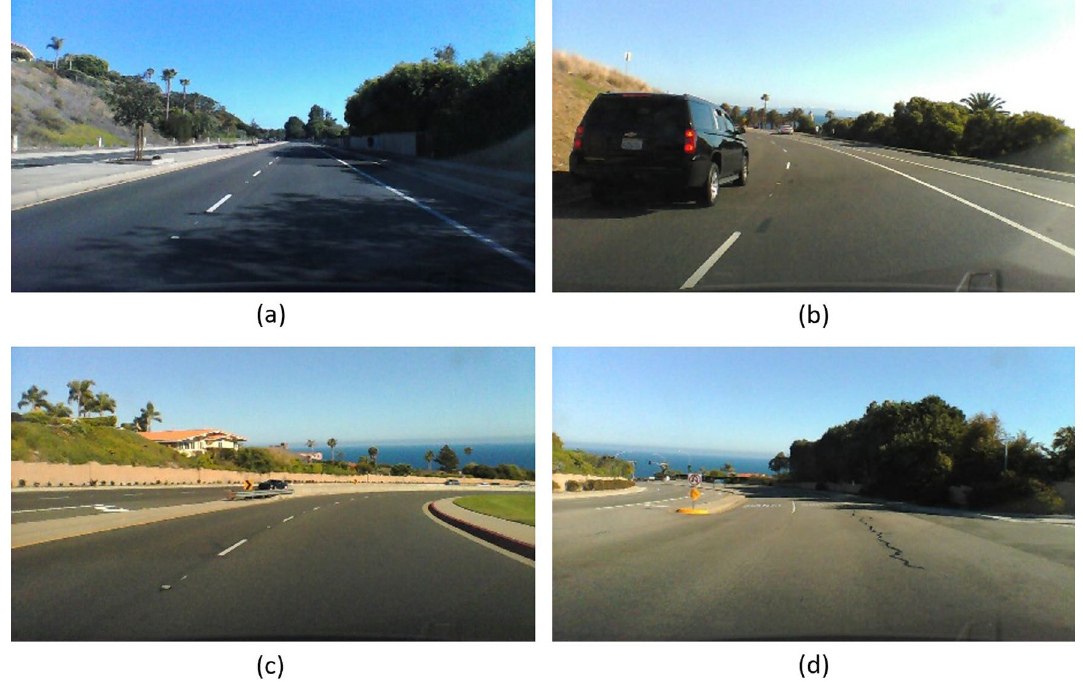
Figure 2. Images from the SullyChen Dataset 43 : ( a ) straight road with trees and shadow, ( b ) road with left curve with obstacle (car), ( c ) road with right curve ( d ) road with a gradual curve to the left with traffic